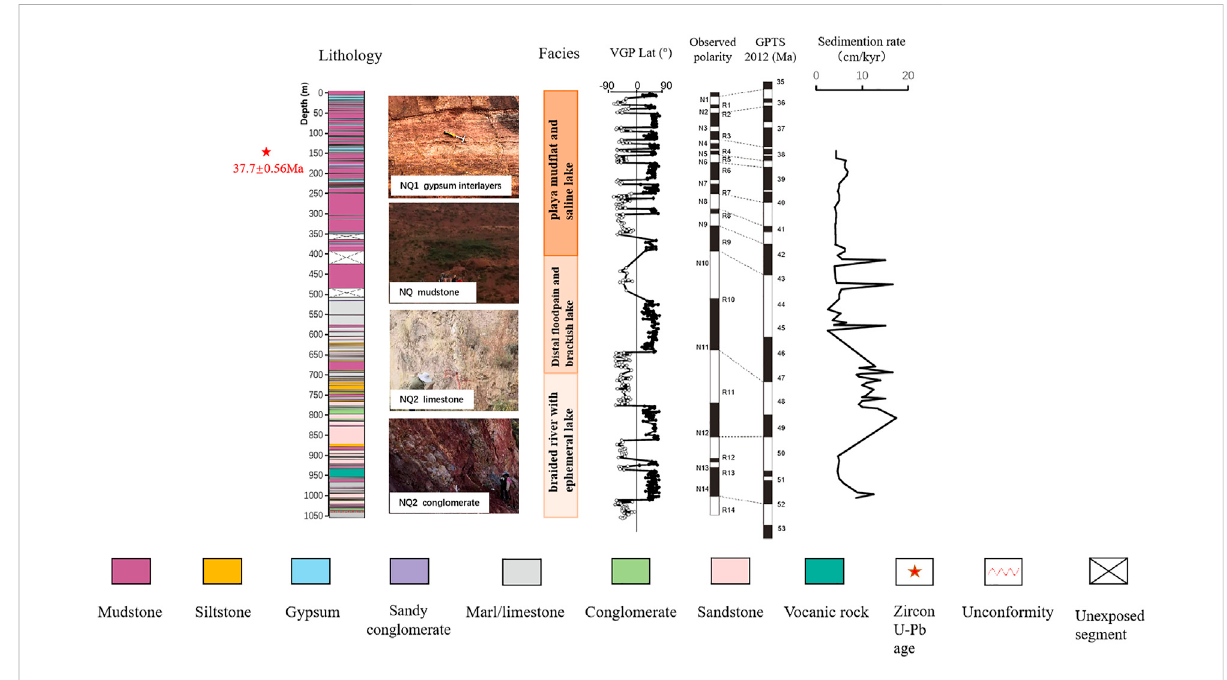
FIGURE 2 Sampling and chronological map of the Nangqian